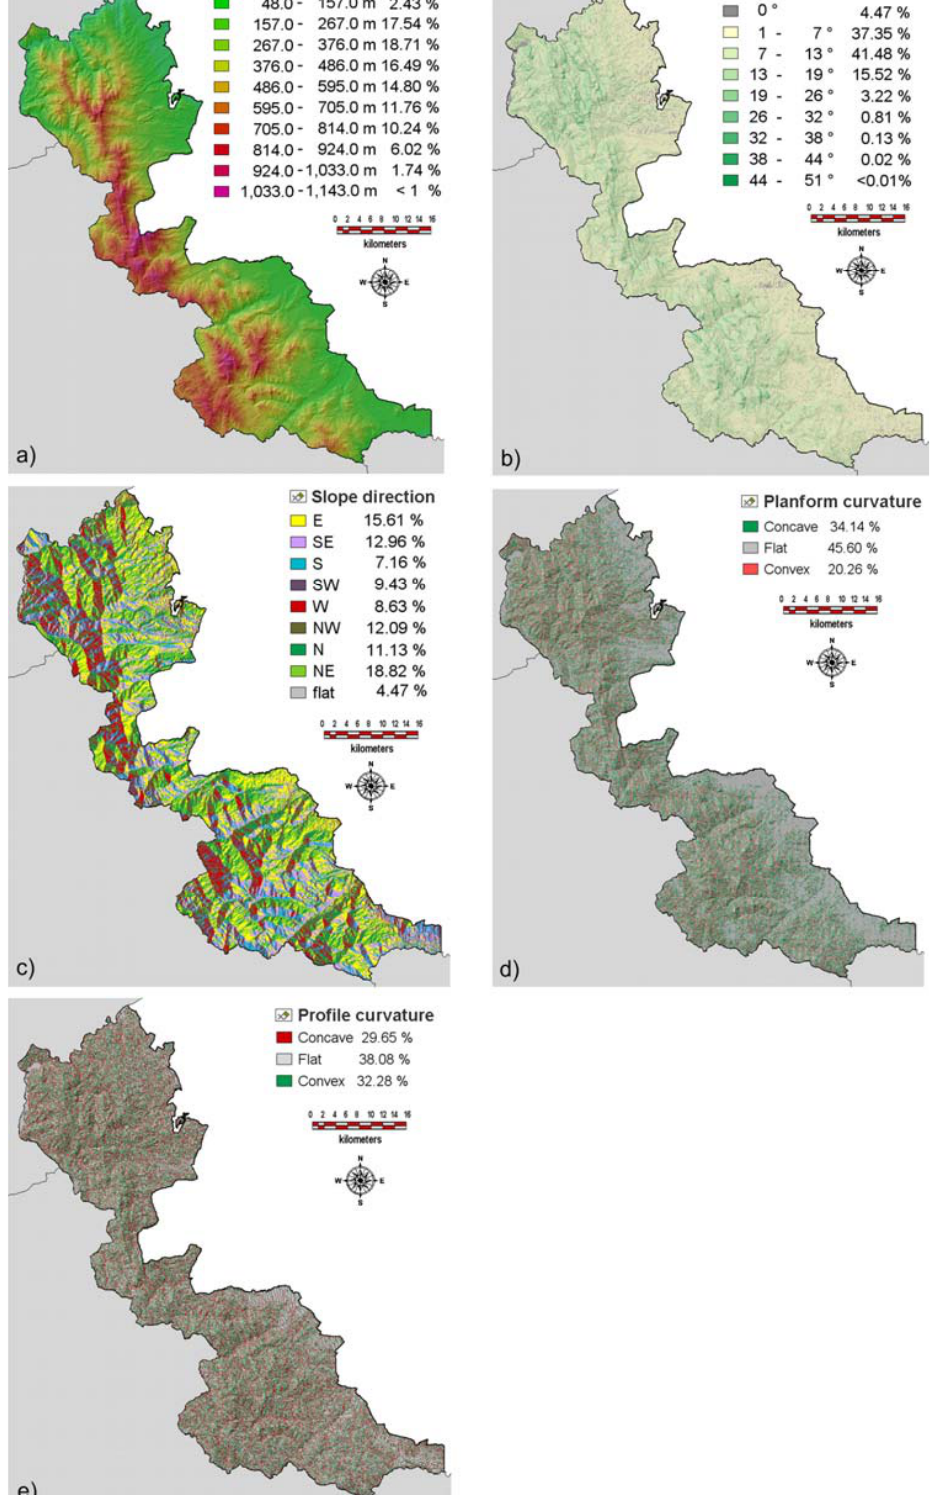
Fig. 4. Maps showing the morphometric factors introduced in Sect. 3.1: (a) altitude; (b) slope angle; (c) slope exposure; (d) planform Figure 4. Maps showing the morphometric factors introduced in section 3.1: a) altitude; b) 2 curvatures, and (e) profile slope angle; c) slope exposure; d) planform curvatures and e) profile curvatures. 3